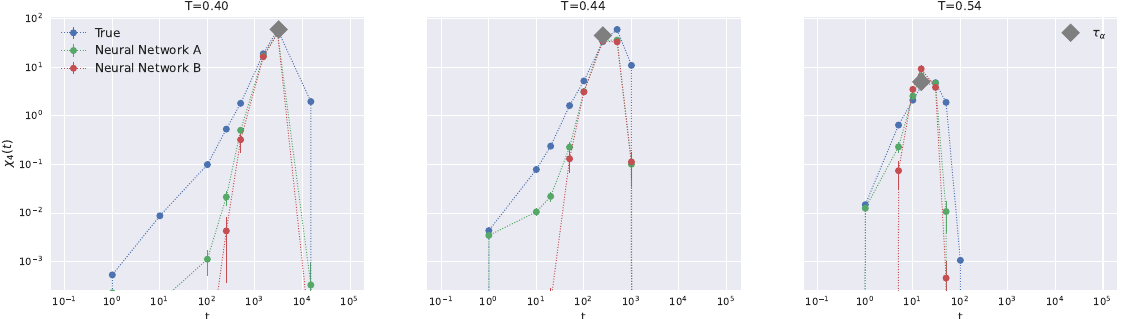
Figure 6. Comparison of the true four-point correlation function χ 4 ( t ) with the predictions provided by the NNs A and B at different temperatures.